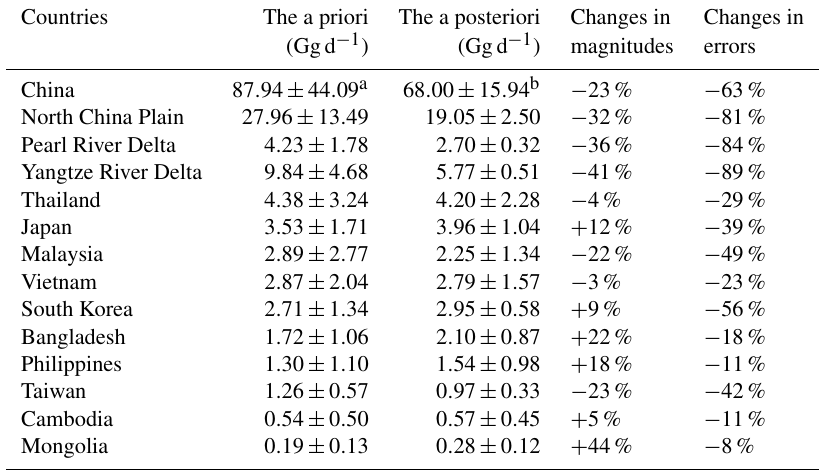
Table 5. NO x emissions before and after carrying out the inversion using OMI / OMPS for different countries in May–June 2016. Countries The a priori The a posteriori Changes in Changes in (Ggd − 1 ) (Ggd − 1 ) magnitudes errors China 87 . 94 ± 44 . 09 a 68 . 00 ± 15 . 94 b − 23% − 63% North China Plain 27 . 96 ± 13 . 49 19 . 05 ± 2 . 50 − 32% − 81% Pearl River Delta 4 . 23 ± 1 . 78 2 . 70 ± 0 . 32 − 36% − 84% Yangtze River Delta 9 . 84 ± 4 . 68 5 . 77 ± 0 . 51 − 41% Thailand 4 . 38 ± 3 . 24